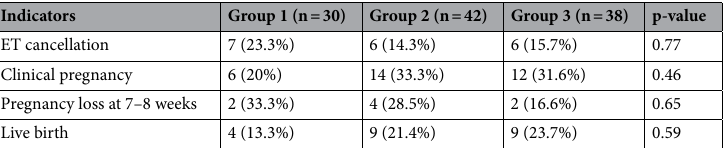
Table 5. Reproductive outcomes for Groups 1–3. The data are presented as raw counts and % incidence, subject to exact Fisher